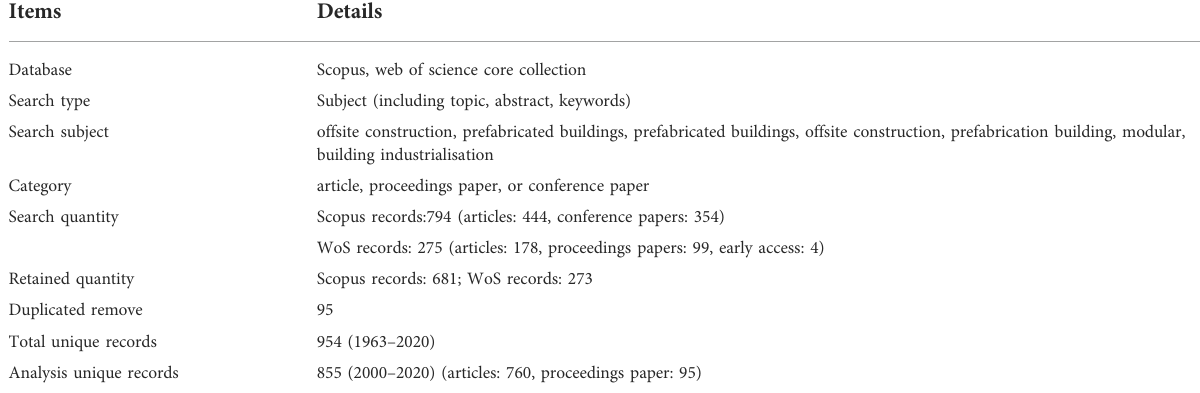
TABLE 2 Data sample